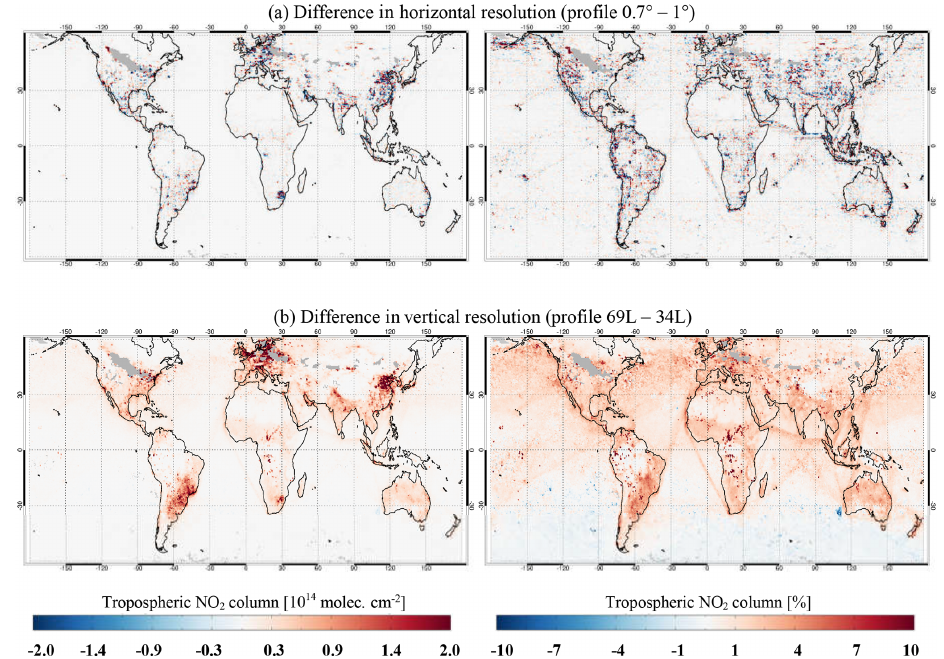
Figure 9. Absolute and relative differences in the tropospheric NO 2 columns retrieved by altering the model resolutions for IFS (CBA) a priori NO 2 profiles in February 2010. The tropospheric NO 2 columns are compared for a 1 and 0.7 ◦ grid (a) and for 34 and 69 layers (b) . Only measurements with a cloud radiance fraction less than 0.5 are included.